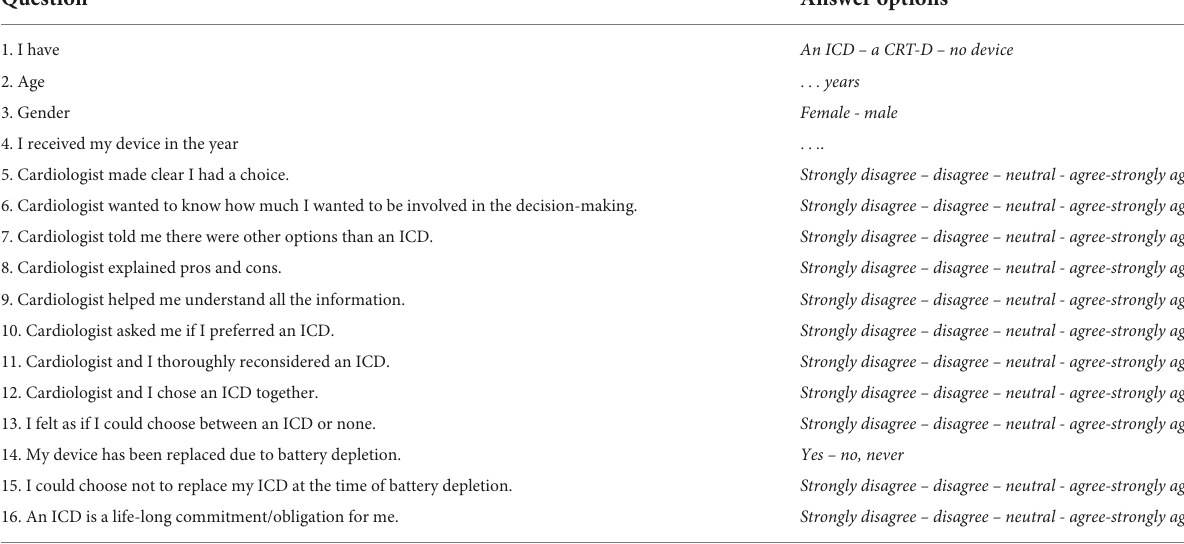
TABLE 1 Modified 9-item Shared Decision-Making Questionnaire (SDM-Q-9) with additional questions for regional ICD patient